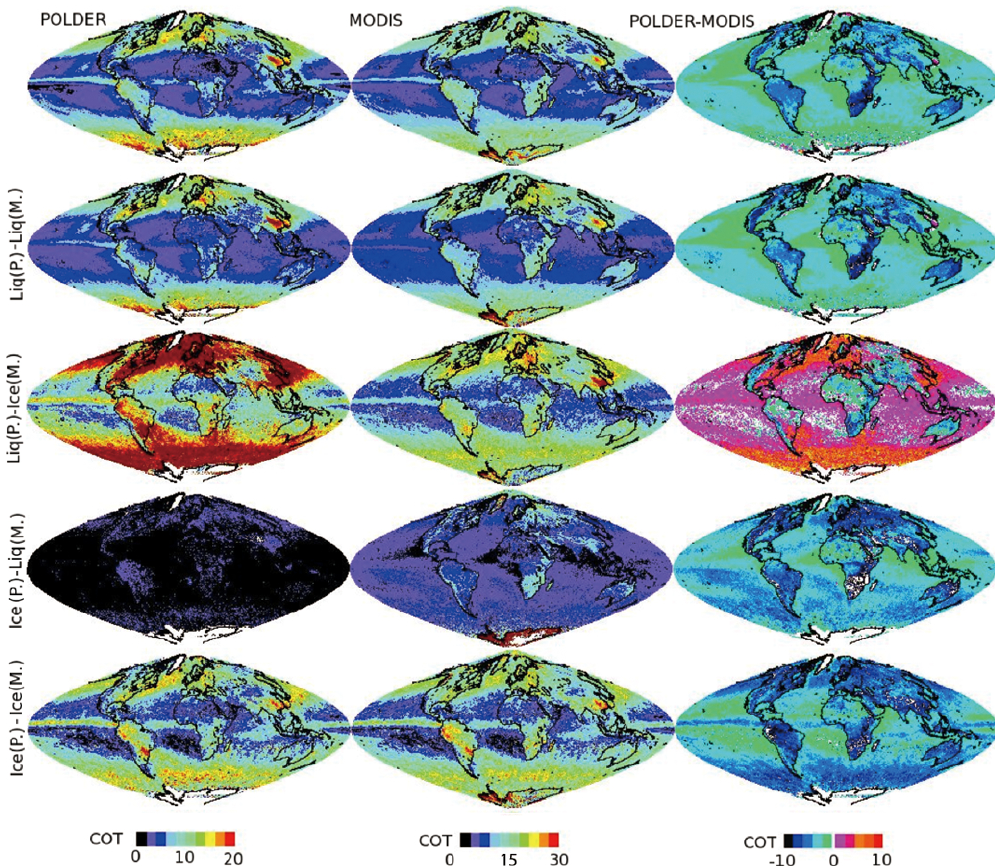
Fig. 1. Geographical distributions of mean POLDER COT (first column), MODIS COT (second column) and the corresponding COT dif- ferences (POLDER-MODIS) (third column) for all the clouds (first line) and clouds separated in 4 different phase classes: POLDER-liquid MODIS-liquid (second line), POLDER-ice MODIS-ice (third line), POLDER-liquid MODIS-ice (fourth line) and POLDER-ice MODIS- liquid (fifth line). Important note, for clarity reason, color scales are different for POLDER and MODIS